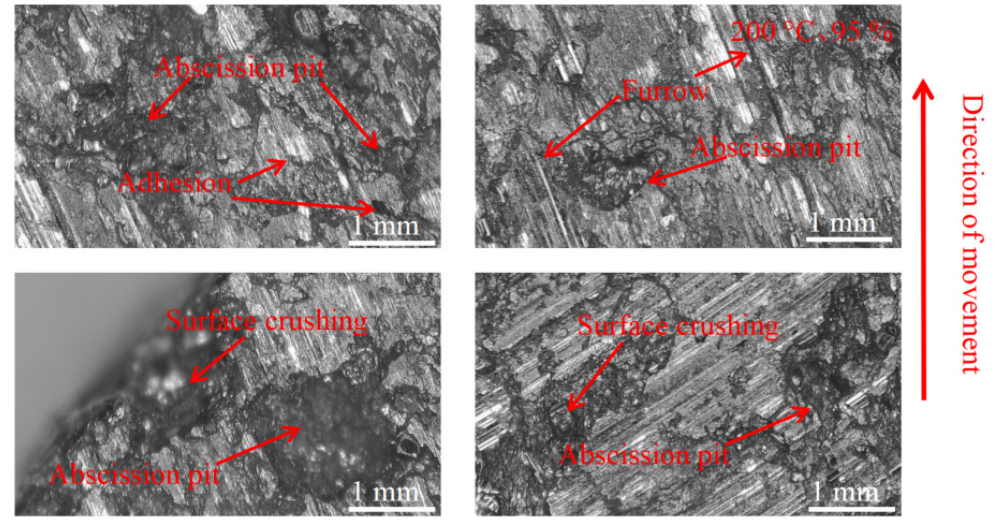
◦ C and 95% ambient